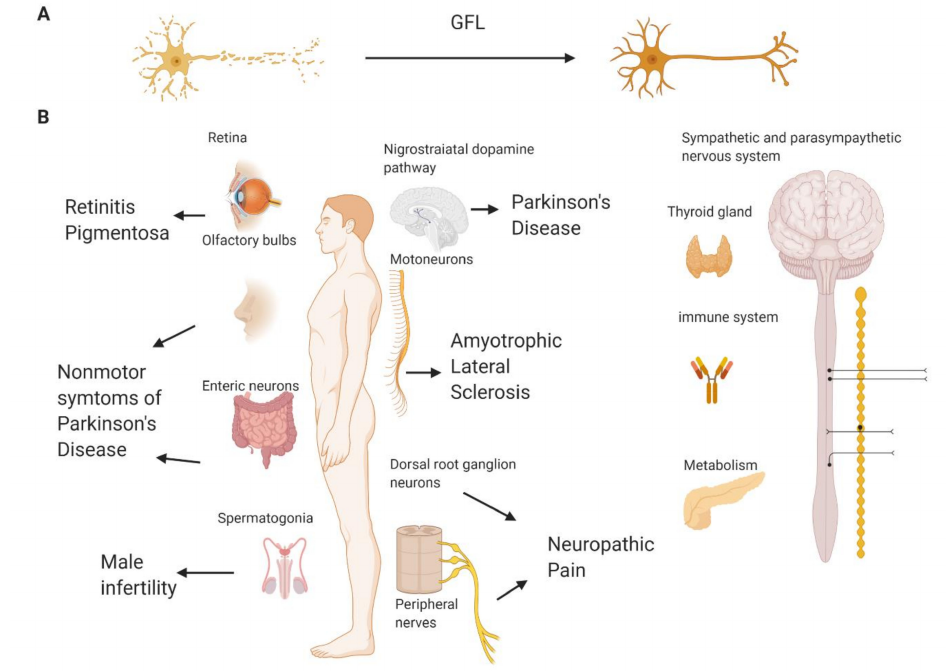
Figure 1. The biological e ff ects of glial cell line-derived neurotrophic factor family ligands (GFLs) in the adult organism and potential pathological conditions that these proteins may cure. ( A ) GFLs support and restore degenerating neurons of di ff erent types. ( B ) GFLs may reduce the degeneration of retinal cells and, therefore, have potential in the treatment of retinitis pigmentosa; support the survival and guide migration of olfactory, dopamine and enteric neurons and may alleviate nonmotor and motor symptoms of Parkinson’s disease; support the survival and functioning of sensory neurons, thus reducing neuropathic pain symptoms, and are important for the survival of motoneurons, thus having the potential to alleviate amyotrophic lateral sclerosis. Outside the nervous system, glial cell line-derived neurotrophic factor (GDNF) is important for spermatogenesis and can have potential in the treatment of male infertility or the development of male contraceptives. GFLs have e ff ects in sympathetic and parasympathetic neurons a ff ecting multiple body functions. persephin (PSPN) and its functional receptor are expressed in the thyroid gland and has a role in thyroid cancer. Growth di ff erentiation factor-15 (GDF15) has a role in regulating the immune system and metabolic conditions. Neurturin (NRTN) supports β cells in the pancreas, but this e ff ect is indirect. GDNF is also important for kidney development in fetuses, but in adult organisms, its role for kidneys has not been shown. Created with